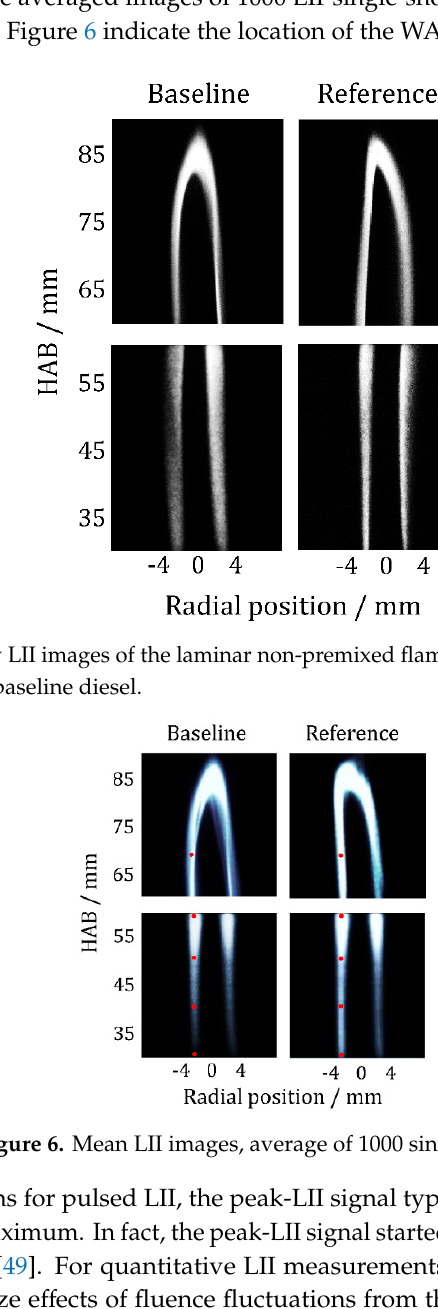
Figure 6. Mean LII images, average of 1000 single-shots.